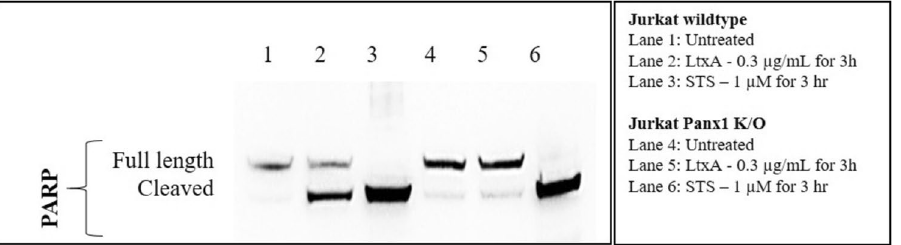
Figure 8. LtxA induced PARP cleavage in Jurkat Wildtype and Panx1 K/O cells. Wild-type and Panx1 K/O Jurkat cells were left untreated or treated with 0.3 µg/mL of LtxA or 1 µM STS for 3 h. Western blots were performed to determine the expression of PARP cleavage. While PARP cleavage was detected in LtxA and STS treated Jurkat wild-type cells and in STS treated Panx-1 K/O cells, no PARP cleavage was detected in LtxA treated Panx-1 K/O cells. β-Actin was used as the loading control (data not shown). The uncropped gel showing full-length and cleaved PARP is presented in Supplementary Figure S5.